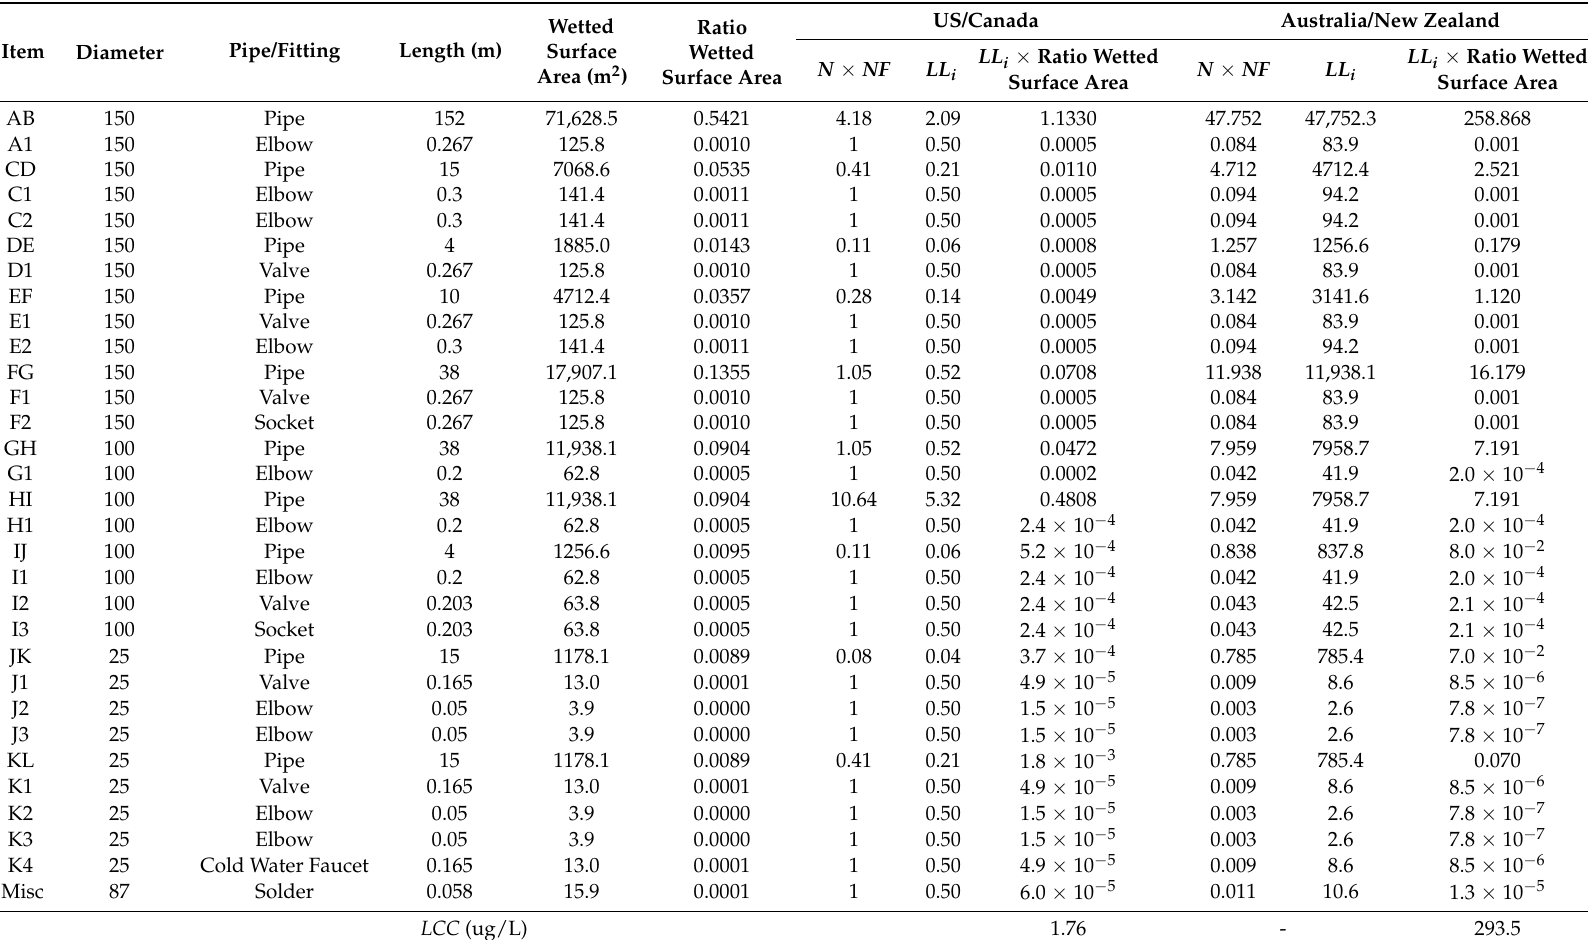
Table 7. Lead leaching concentration ( LLC )